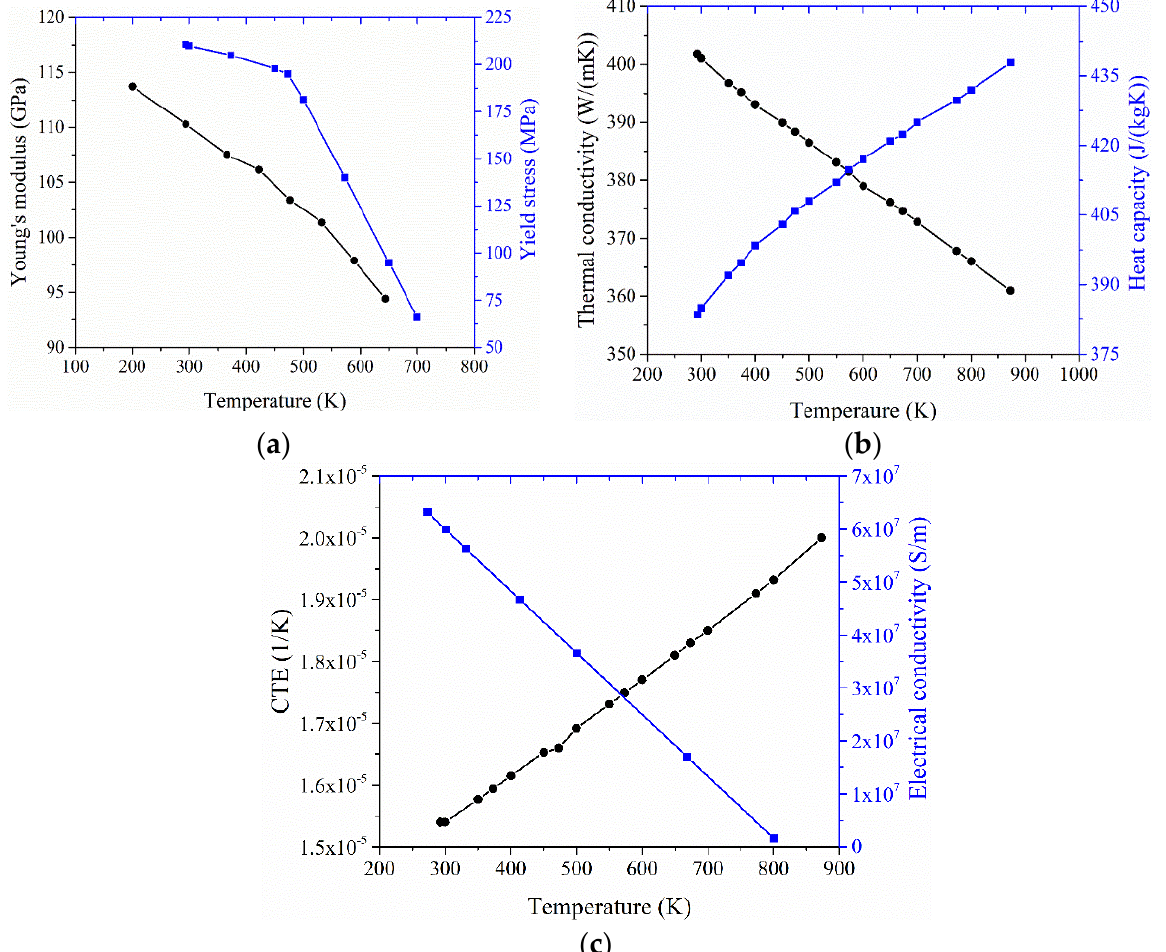
Figure 5. Temperature-dependent properties of copper: ( a ) Young’s modulus and yield stress, ( b ) thermal conductivity and heat capacity, and ( c ) CTE and electrical conductivity [37]. Table 2. Parameters in the modeling of electrical contacts.